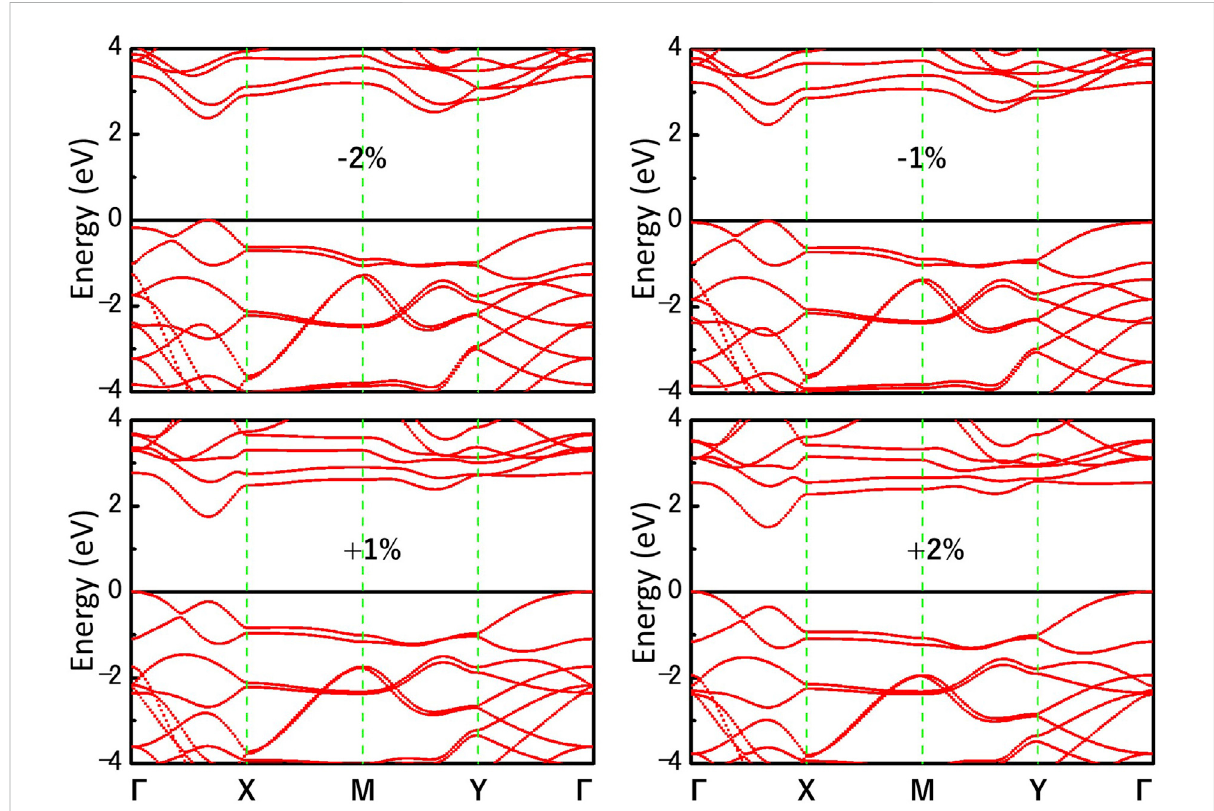
FIGURE 5 Band structures of MoWS 4 monolayer under the biaxial strain from − 2 to 2% are calculated by HSE06 functional.